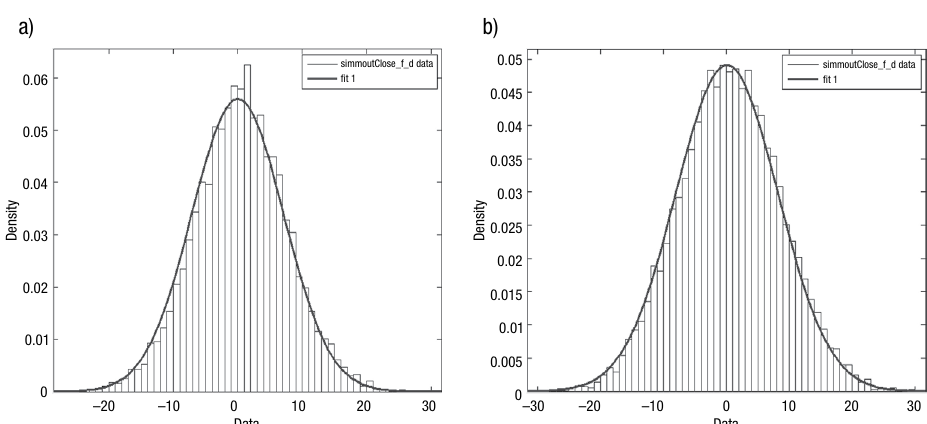
Fig. 7. Primary RW with a price inertia feedback (a) and without feedback